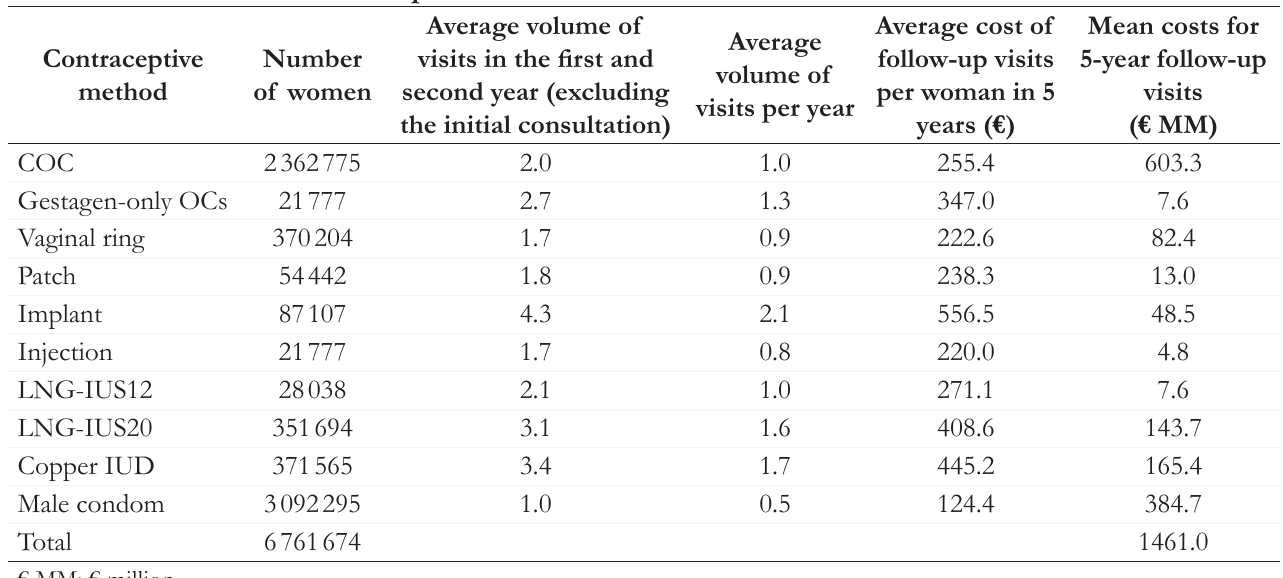
Table 3. Total Cost of Follow-up Consultations